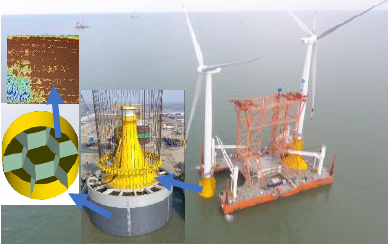
Figure 1. Vacuum preloading process after installation.